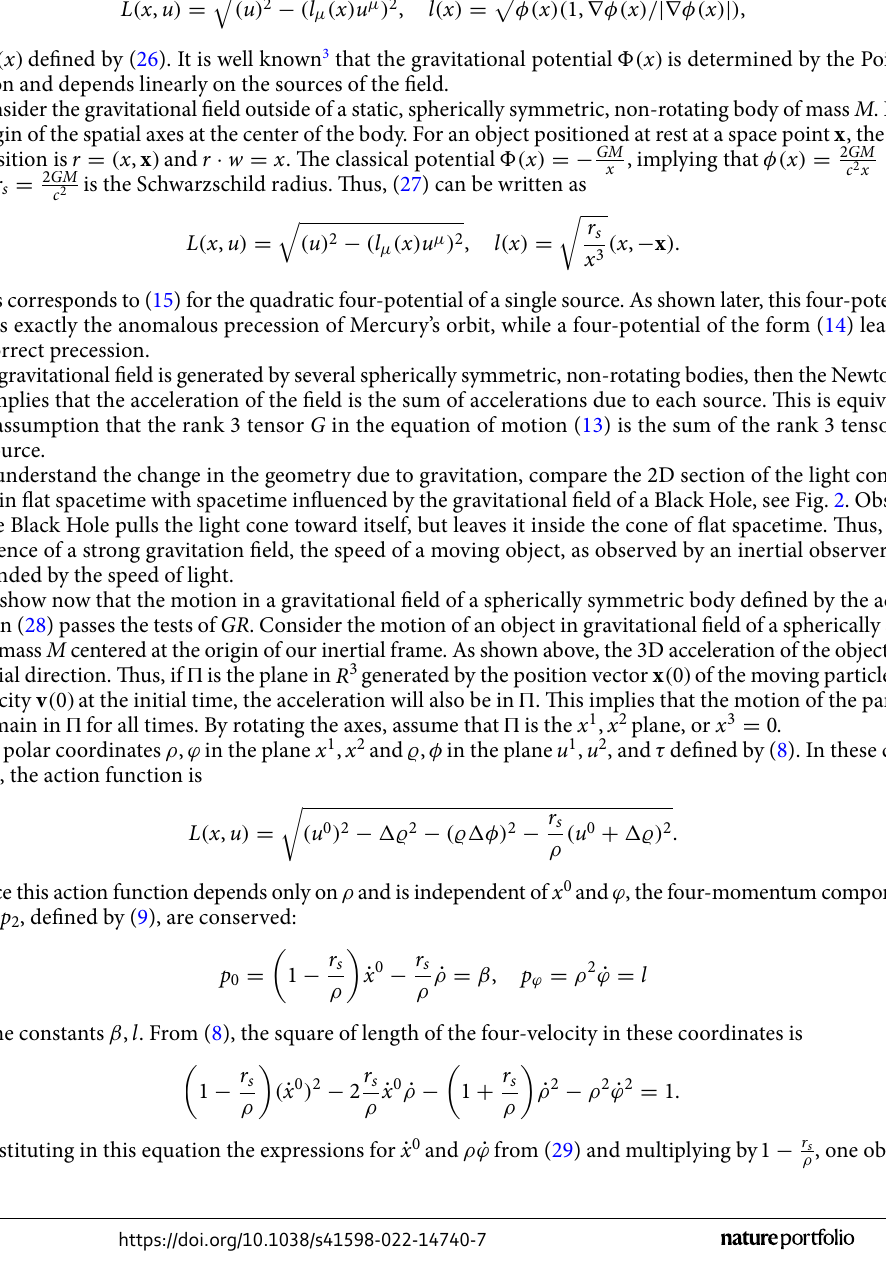
The null covector l can be written as l = l 0 ( 1, n ) , where n is a norm one vector in R 3 in the direction of the propagation of the field. Since the propagation of a static gravitational field with potential �( x ) is in the direction of ∇ �( x ) , by the definition of l , n = ∇ φ( x )/ |∇ φ( x ) | . Thus, the action function for a static gravitational field with Newtonian potential �( x ) is